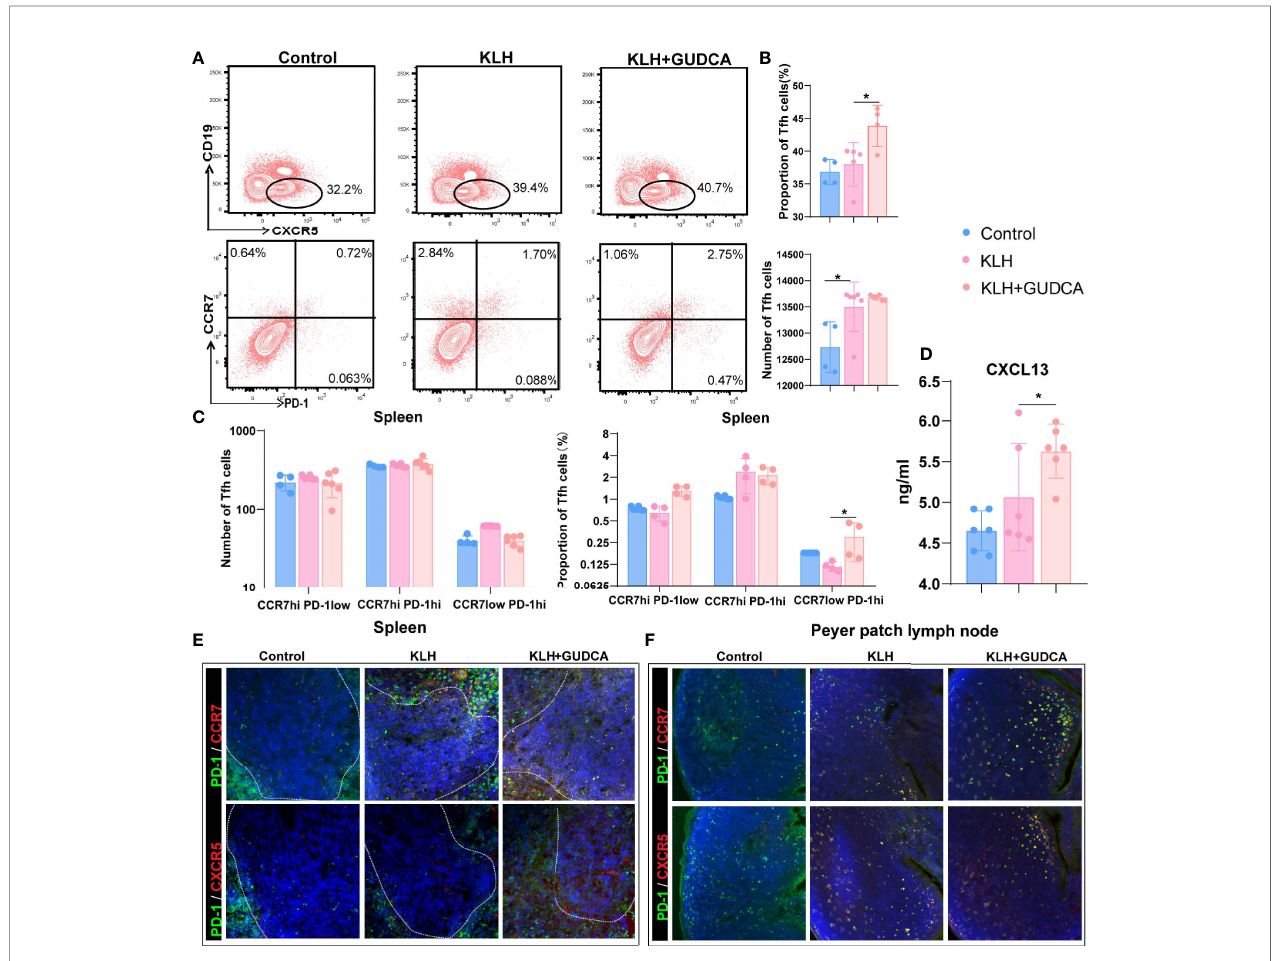
FIGURE 3 | Glycoursodeoxycholic acid administration inhibited the T follicular helper (Tfh) cells in the spleen in KLH-stimulated animals. (A) The differentiated plasma cells from B cells were detected using fl ow cytometry in KLH-stimulated animals. (B) Flow cytometric analysis of CD4+CD19-CXCR5+ T cells. (C) Flow cytometric analysis of CCR7 hi PD-1 low resting Tfh, CCR7 hi PD-1 hi -activated Tfh, and CCR7 low PD-1 hi Tfh cells. (D) Expression of CXCL13 in peripheral blood of KLH-stimulated animal using enzyme-link immunosorbent assay. (E, F) Representative immuno fl uorescence image of CXCR5+PD-1 hi Tfh and CCR7+PD-1 hi Tfh cells in the spleen and Peyer ’ s patch lymph node of the KLH-stimulated animal. N = 6, *p < 0.05. KLH, keyhole limpet haemocyanin; GUDCA, glycoursodeoxycholic